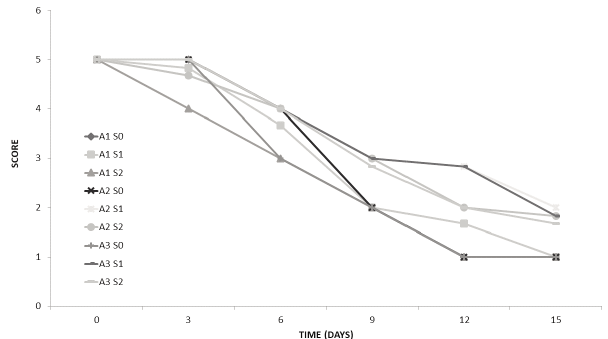
Fig. 5 - Effect of alginate based edible coating-betel essential oil on panelist preferences of rose-apple cv.